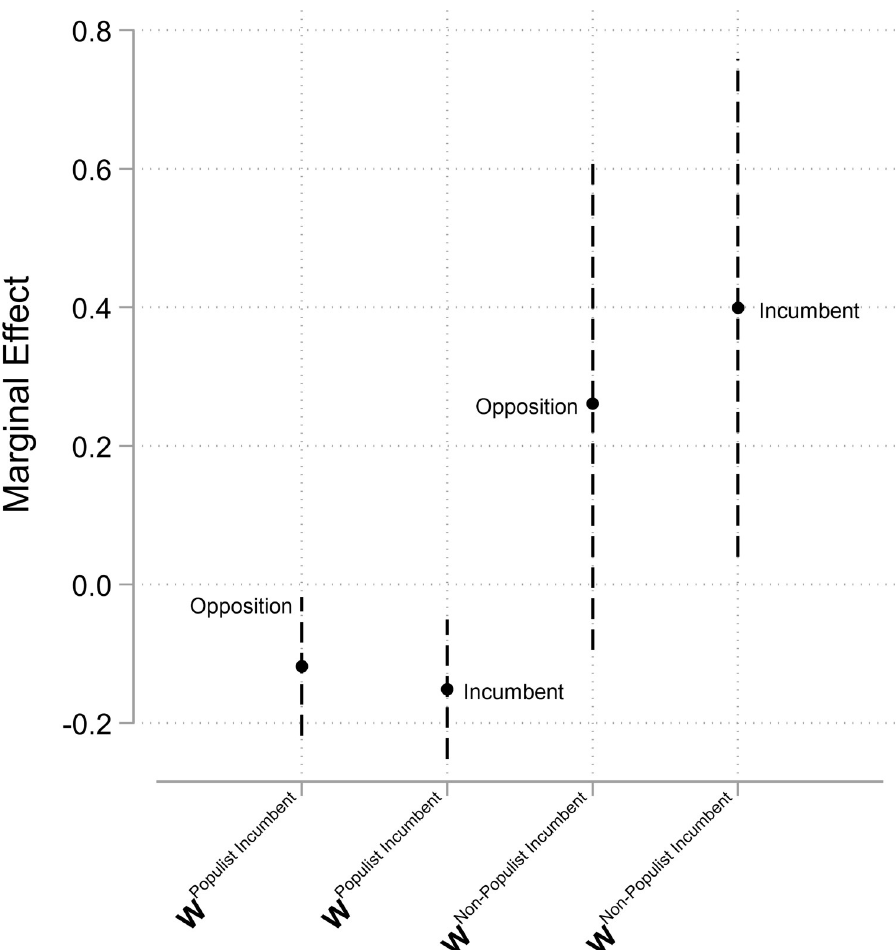
Fig 2. Asymptotic long-term effects. Notes . Point estimates pertain to average marginal effects. Dashed lines signify 95 percent confidence intervals. Estimates based on Model 3.